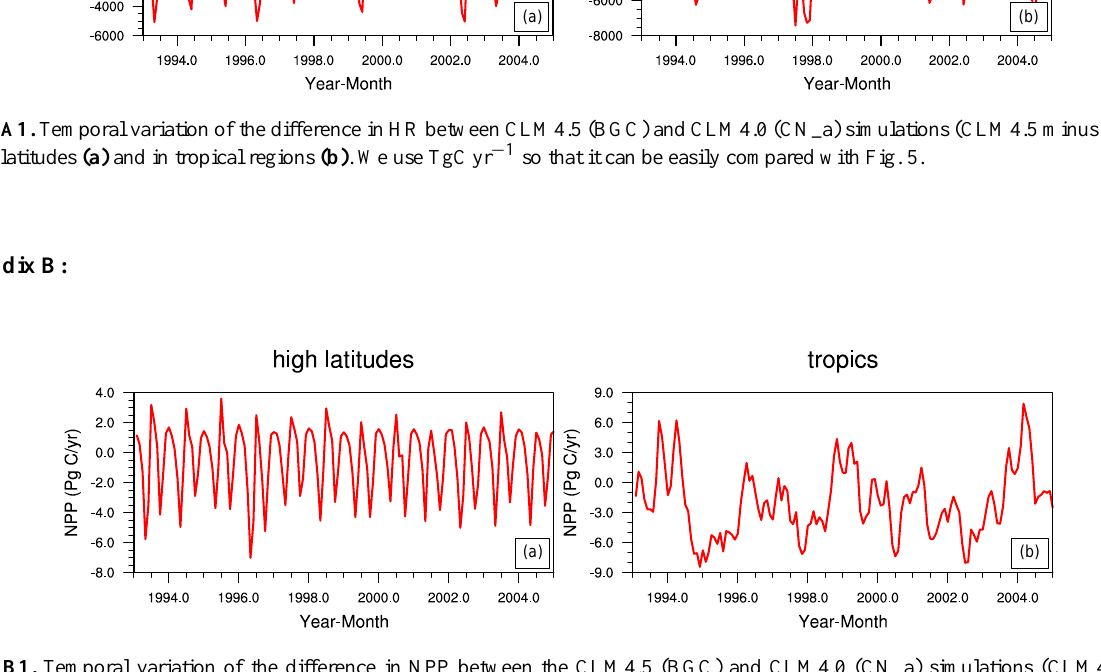
Figure B1. Temporal variation of the difference in NPP between the CLM4.5 (BGC) and CLM4.0 (CN_a) simulations (CLM4.5 minus CLM4.0) at high latitudes (a) and the tropics (b) .